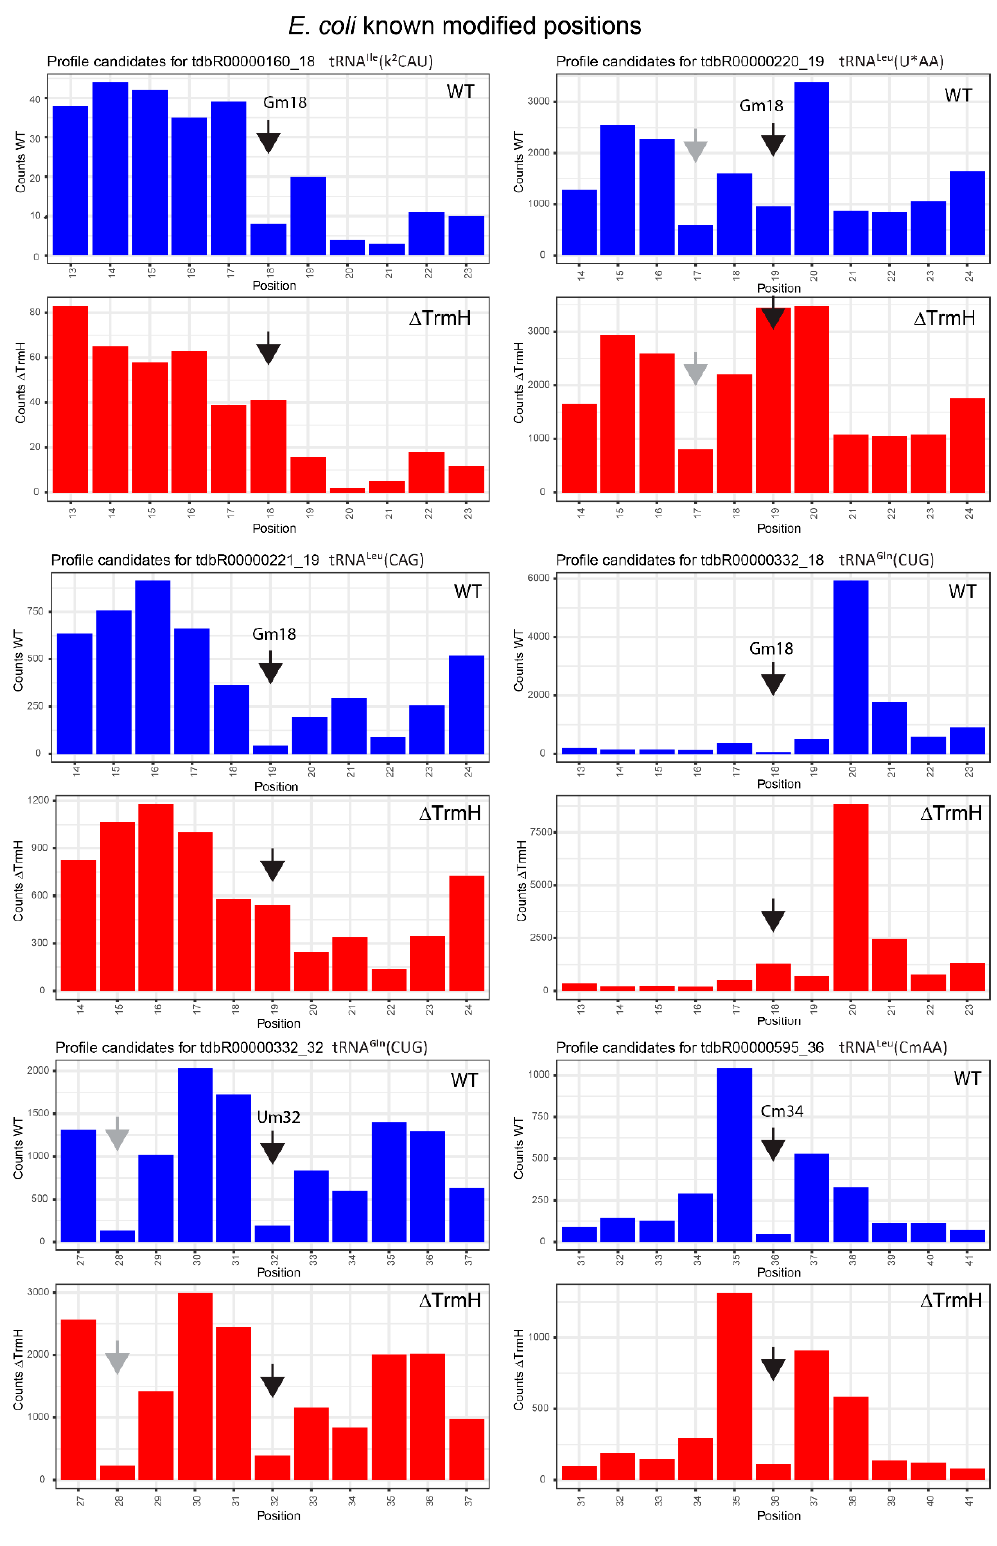
Figure 5. Representative cleavage profiles for six E. coli tRNA species for wild ‐ type (WT) and Δ TrmH strains. The cumulated number of the 5 ′ ‐ and 3 ′ ‐ end extremities at every position is traced as vertical bars. All profiles are centered for the known 2 ′ ‐ O ‐ methylated position shown by the black arrow; false ‐ positive alkali ‐ resistant positions are indicated by gray arrows.